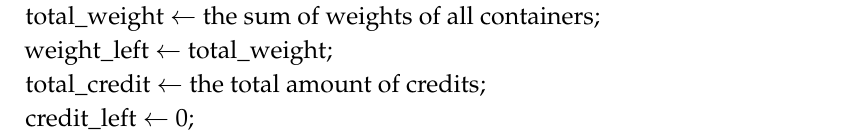
Algorithm 1: Combination of the three scheduling policies with the work-conserving